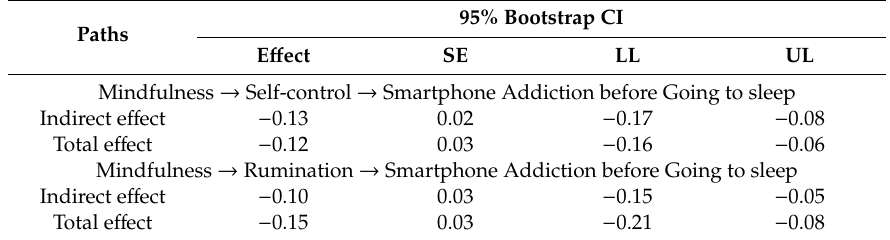
Table 4. Bootstrap tests of the mediating e ff ects of rumination and self-control on the path from mindfulness to smartphone addiction before going to